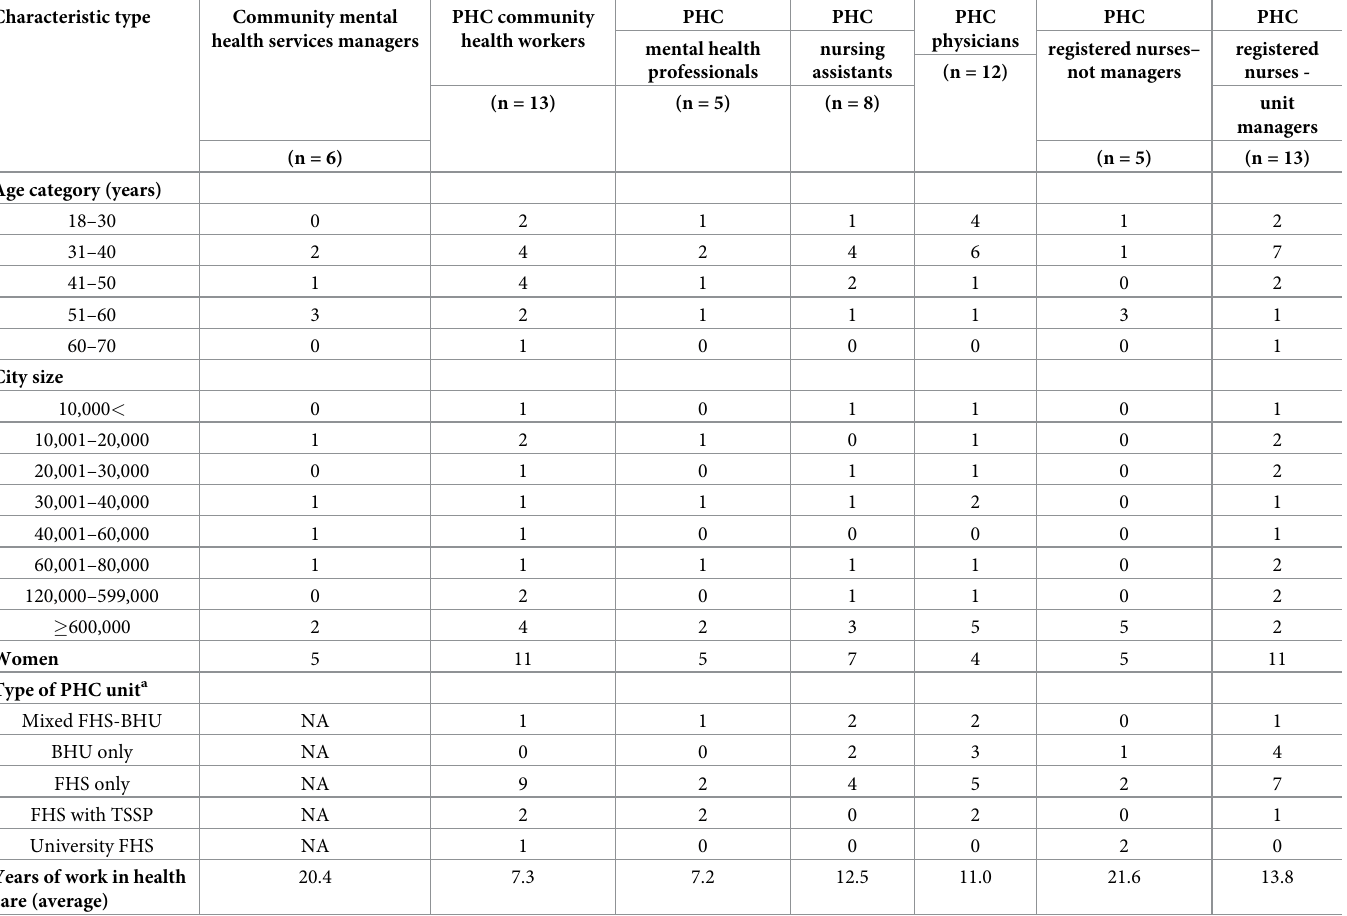
Table 2. Characteristic of interviewed health care professionals (HCP) (N =